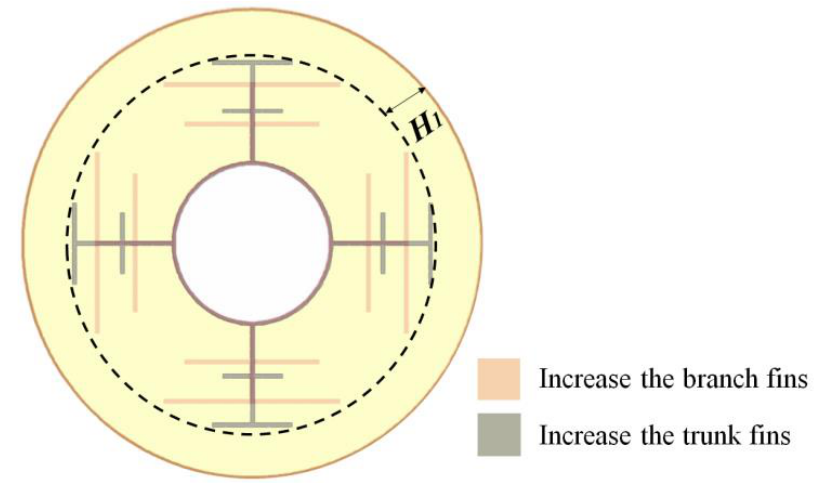
Figure 10. Two modes to increase the fin length. Table 2. Bifurcated fin parameters and discussed cases.